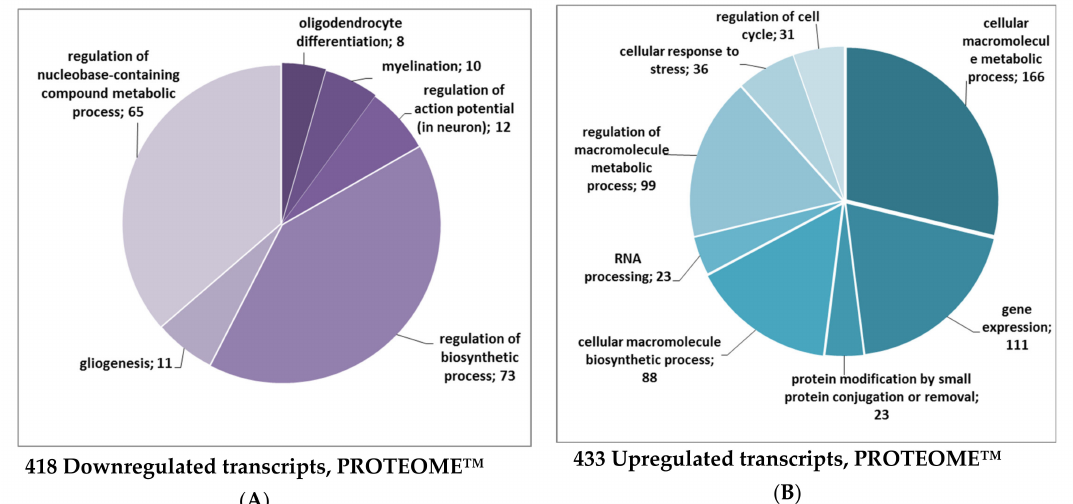
Figure 1. Functional annotation of transcriptome data in terms of Gene Ontology (GO) biological processes. Color intensity reflects the significance of enrichment: darker colors indicate higher statistical significance. The biological process in terms of GO supported the prevalence of downregulated transcripts related to the regulation and development of neurons including those guiding gliogenesis and myelination ( A ). The upregulated transcripts are related to processes involved in the response to DNA damage and consequent regulation of cell death as well as negative regulation of common cellular processes in the population of upregulated transcripts ( B ). Since each gene may be involved in several biological processes, the number of up- and downregulated transcripts does not match the sum of biological processes shown in the Figure. Other explanations are given in the text.